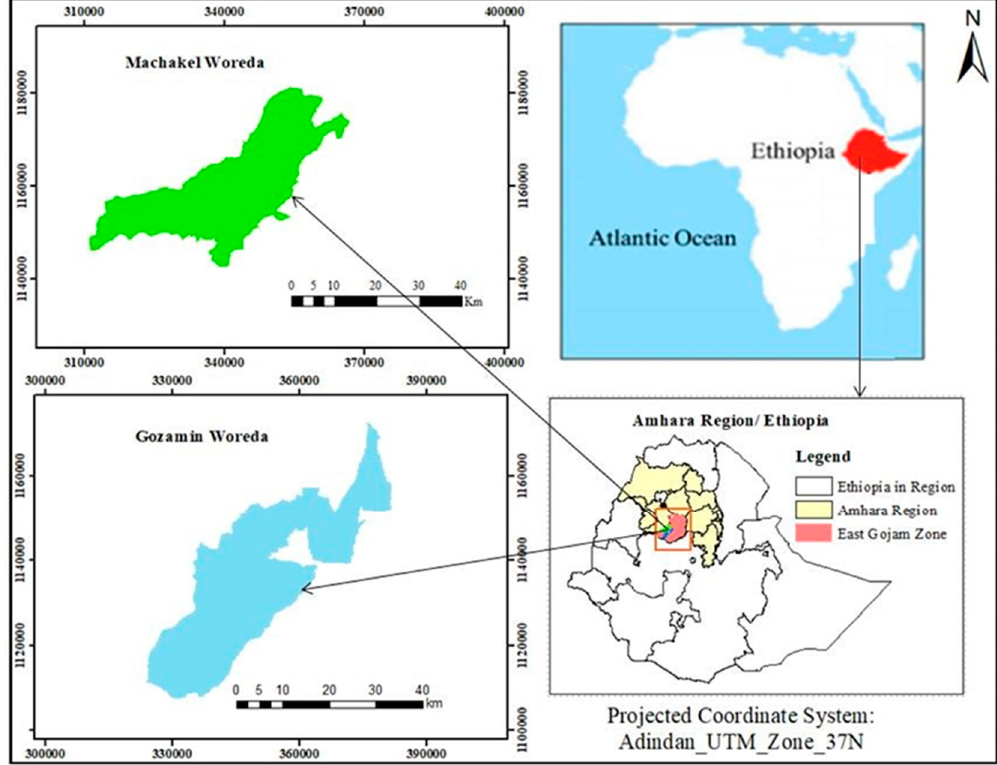
Figure 1. Map of the study area.